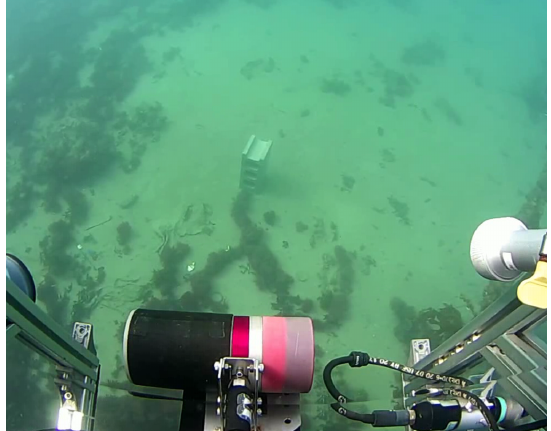
Figure 12. The target object captured by the camera on the AUV: concrete block (0.19 m × 0.39 m × 0.15 m (W × H × D)) deployed on the seabed.